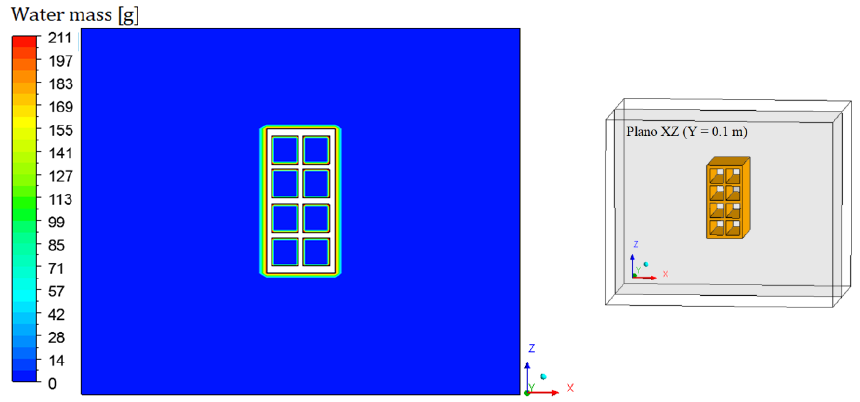
Figure 8. Water mass distribution inside the oven (Plane XZ) for drying at 90 °C (t = 0 min).